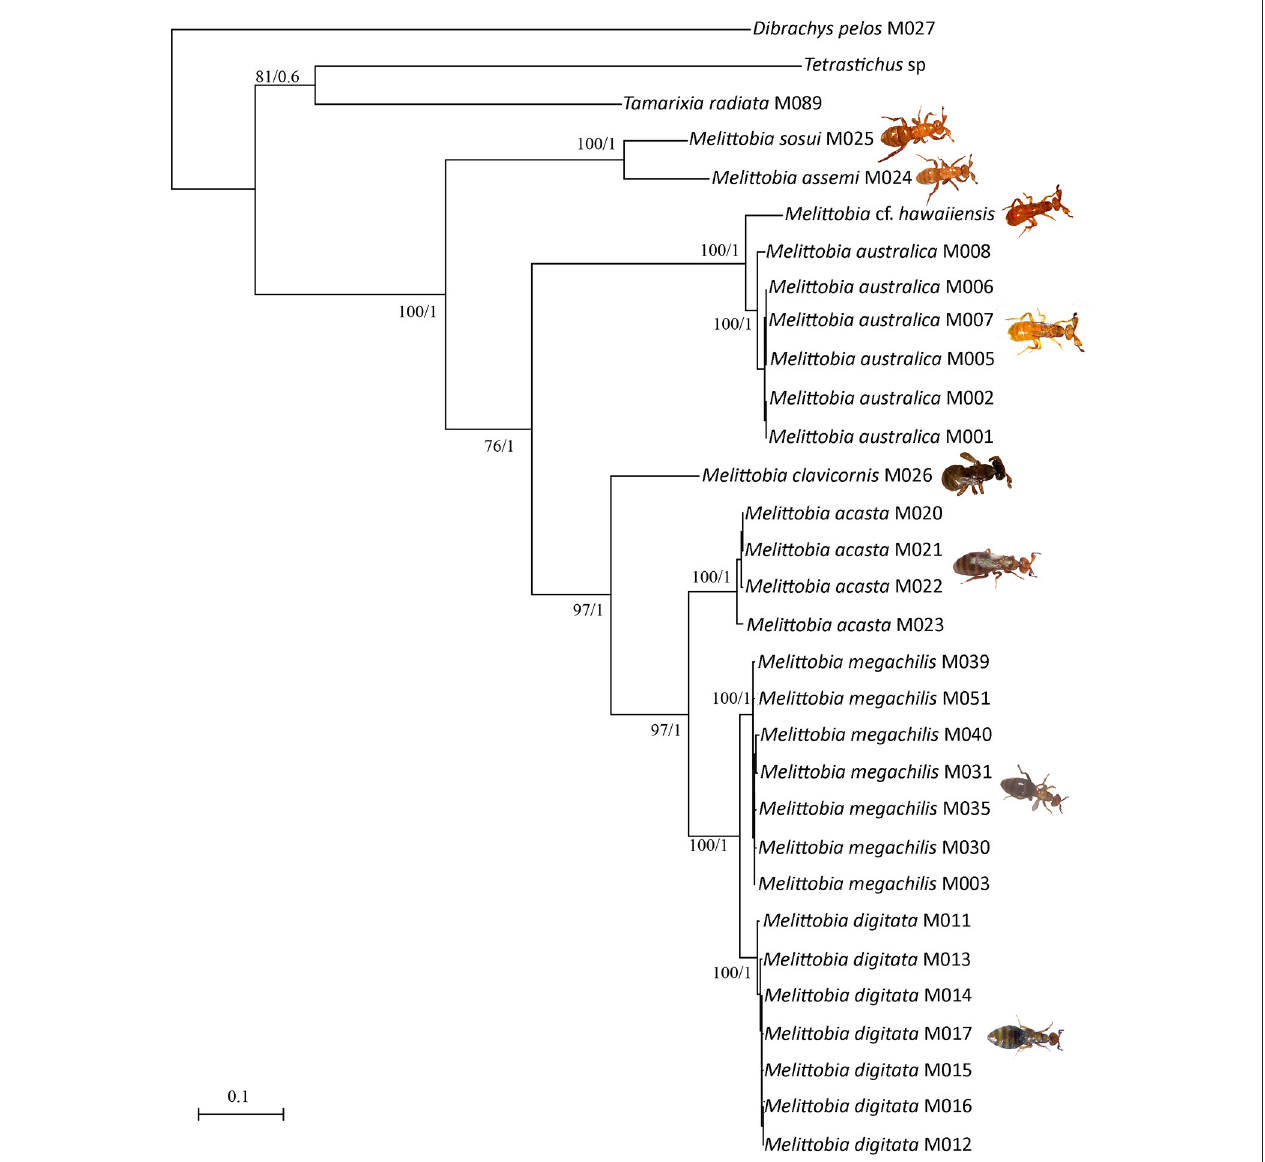
FIGURE 2 | Phylogenetic analyses. Phylogeny of Melittobia species based on phylogenetic analyses of ITS1, ITS2, and the CO1 sequences. Branch lengths are from ML trees. Bootstrap support values of ML analysis and Bayesian posterior probabilities for each branch are indicated before and after a slash, respectively.